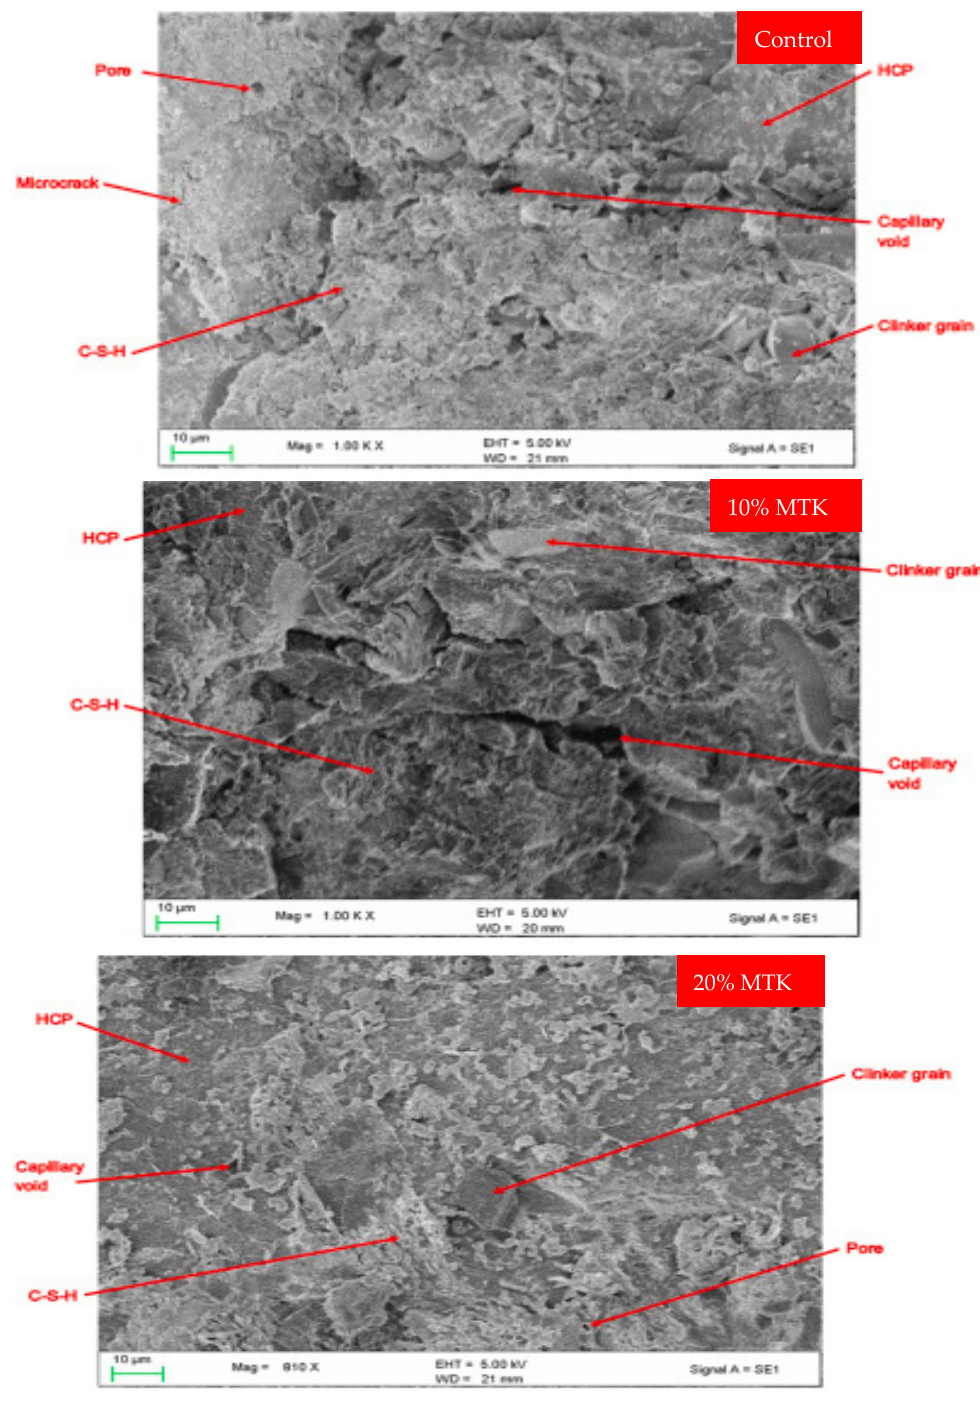
Figure 18. An SEM of concrete with MTK [92].